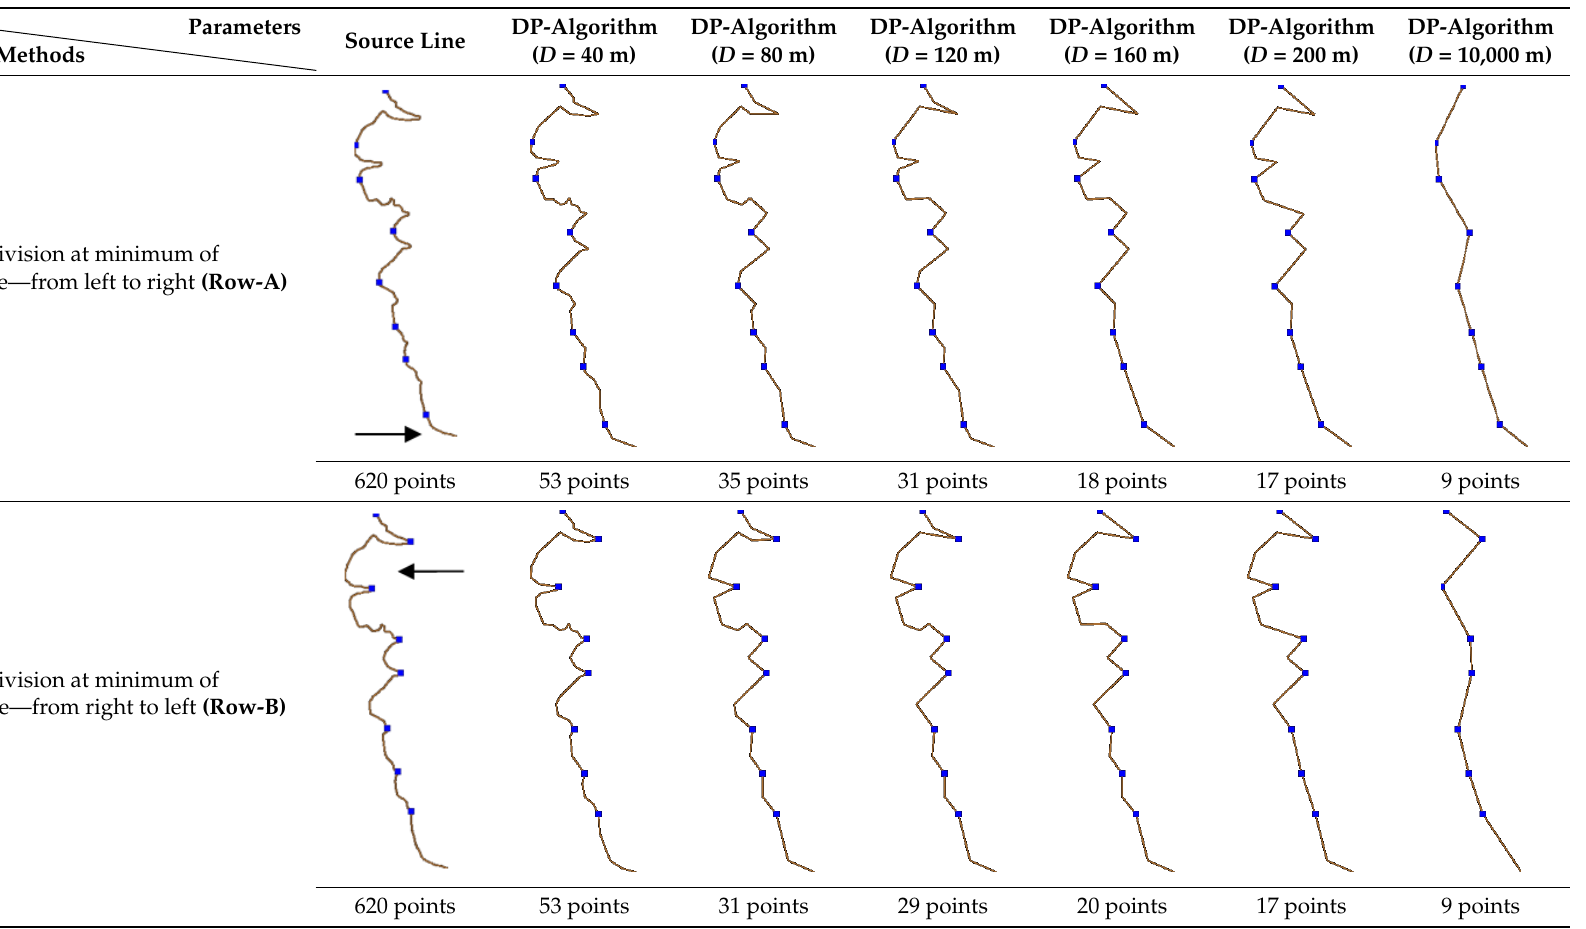
Table 3. Comparison of the different simplified results of contour lines.